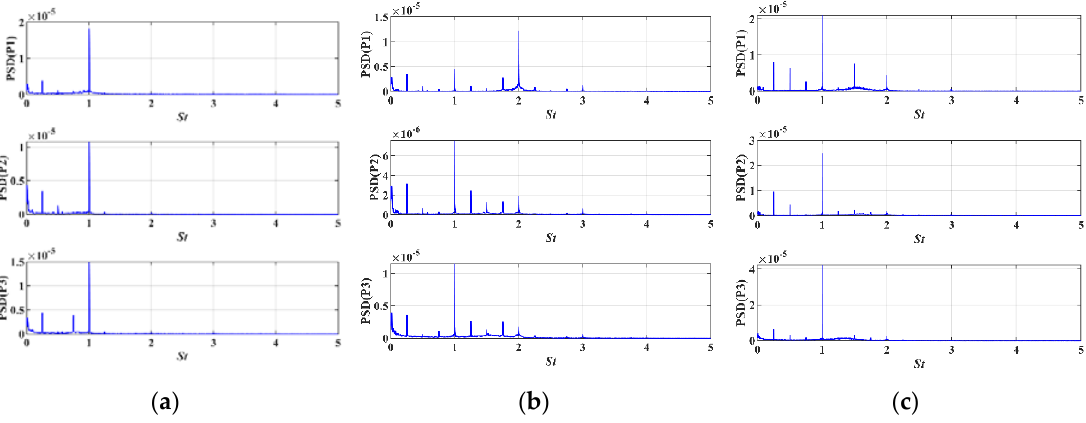
Figure 14. Frequency domain of pressure pulsations for three schemes at H max = 6.5 m: ( a ) H = 204 mm; ( b ) H = 164 mm; ( c ) H = 142 mm.